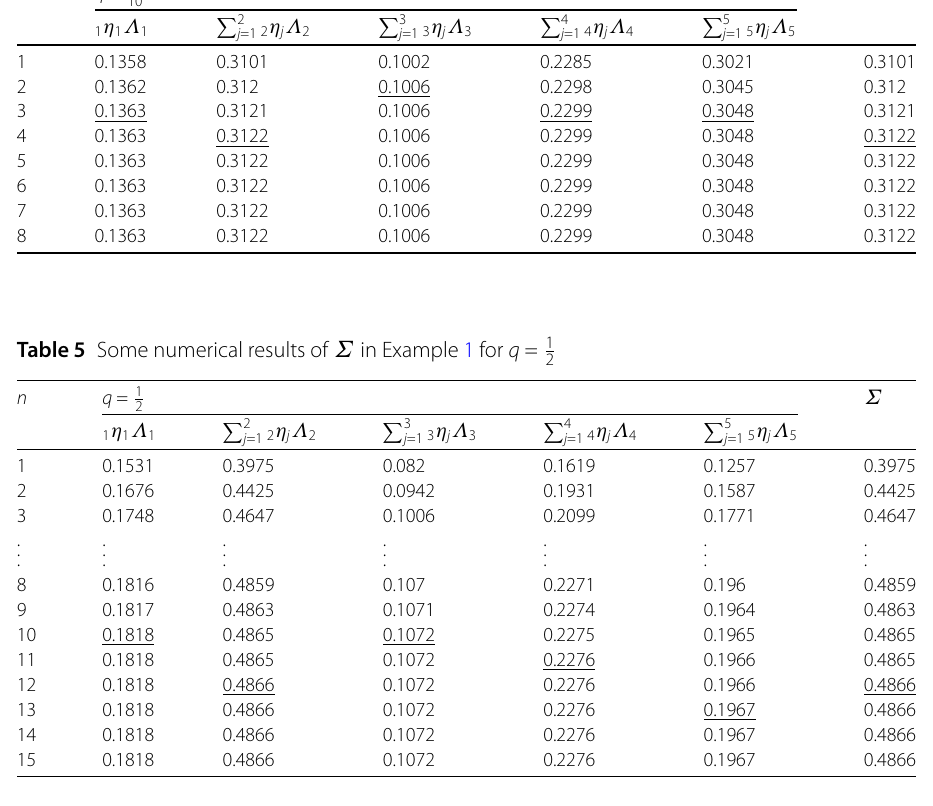
Table 4 Some numerical results of Σ in Example 1 for q = 1